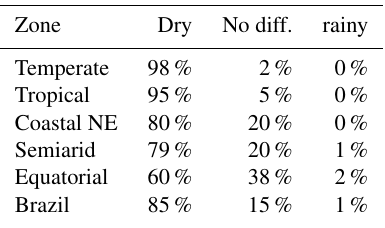
Table 4. Frequency of higher mean temperature during dry and rainy days.